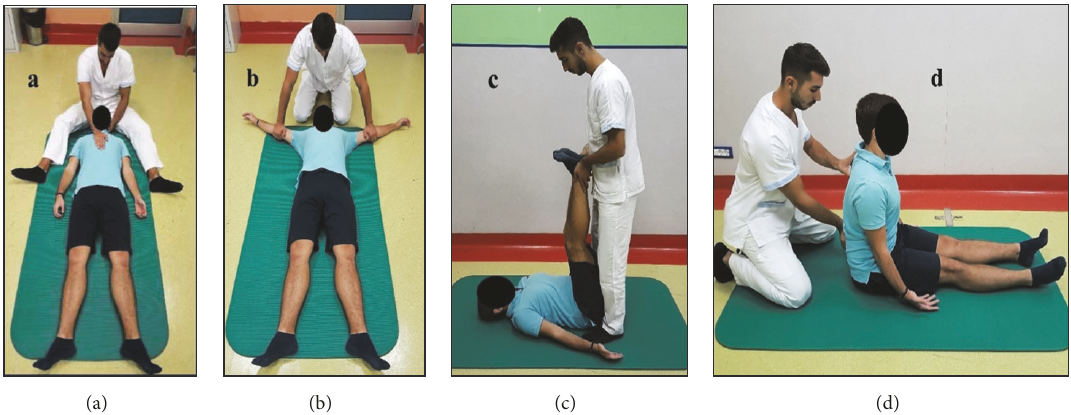
Figure 1: M´ezi`eres rehabilitative method: (a) the first posture, (b) the second posture, (c) the third posture, and (d) variation of the third posture. Source of pictures: UOC Physical Medicine and Rehabilitation Unit, Policlinico Umberto I Hospital, Rome, Italy.